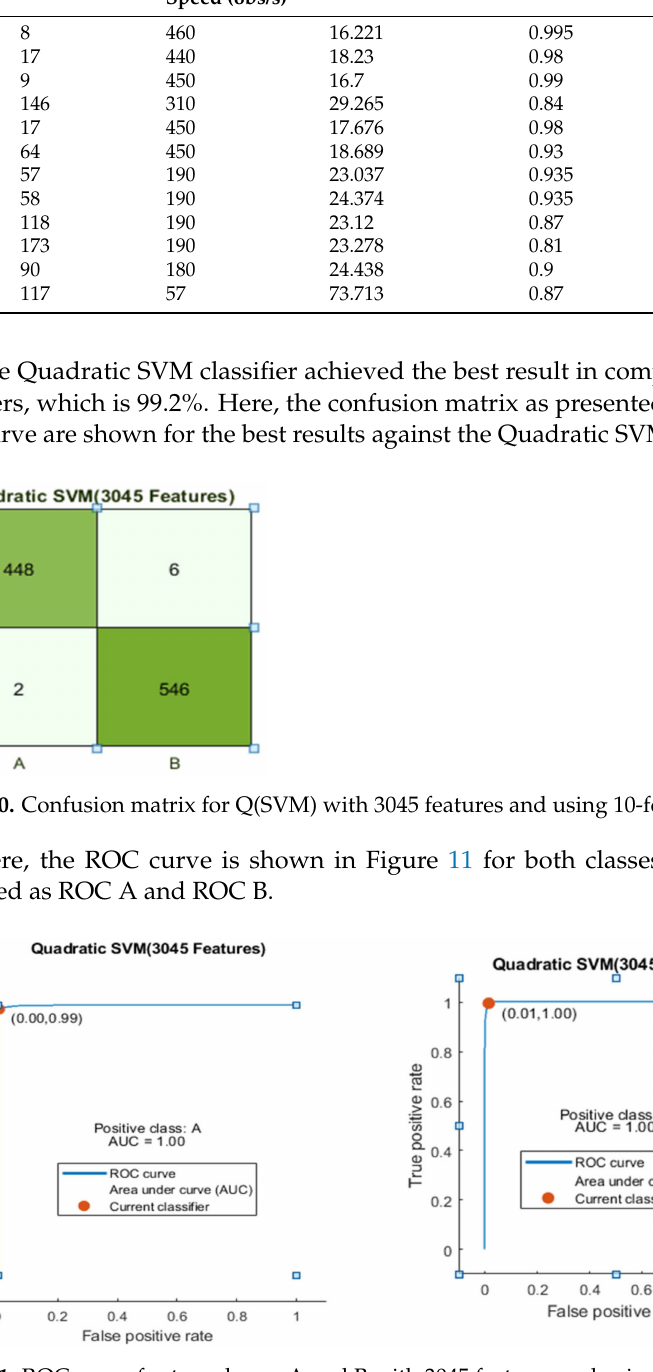
Figure 11. ROC curve for two classes A and B with 3045 features and using 10-fold